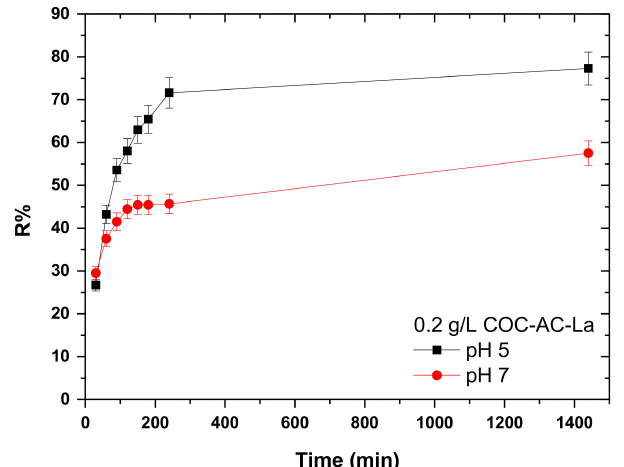
Figure 7. Effect of contact time on the adsorption of Cr(VI) on COC-AC-La; initial Cr(VI) concentration 100 µ g/L, solution pH 5 and 7, dose 0.2 g/L, T = 22 ± 1 ◦ C, in deionized water.